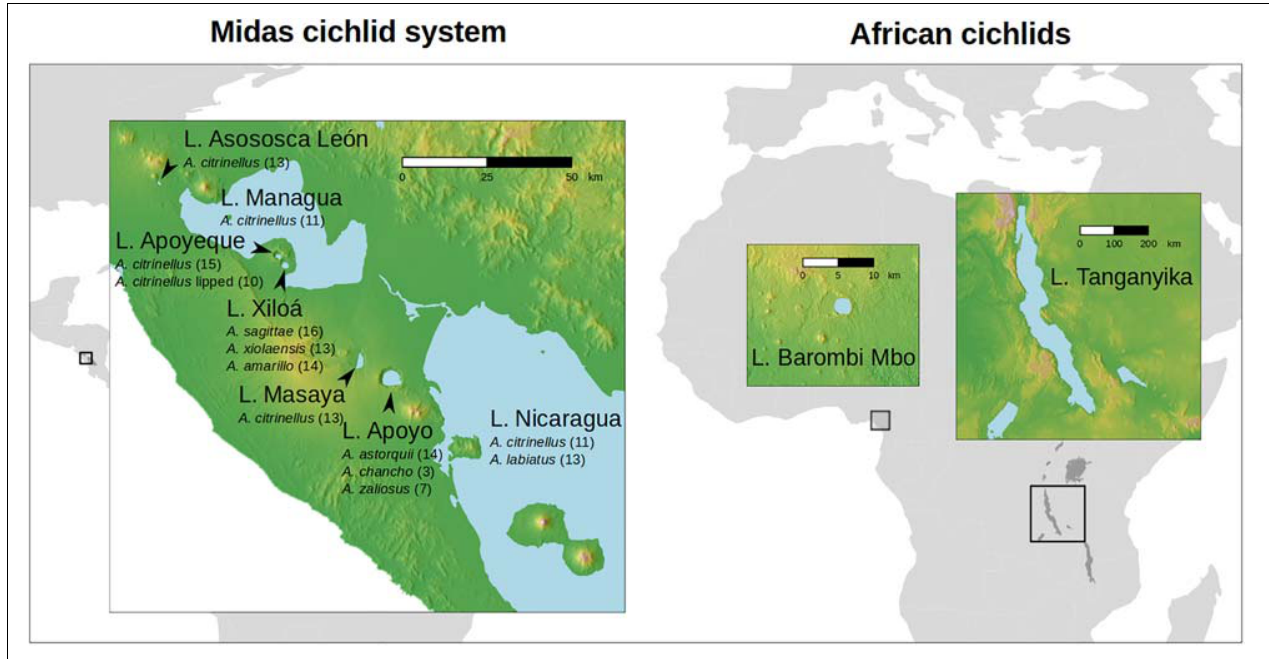
FIGURE 1 | Map of the sampled lakes for the cichlid gut microbiota (seven Central American and two African lakes). Total samples ( N = 274 specimens) encompassed 42 species. For Midas cichlids, sampled species ( N = 13) and specimens ( N = 158) are given below the lake name (number of individuals per species is shown in parentheses, see Supplementary Table S1 for metadata). For the two African lakes, Barombi Mbo and Tanganyika, data were obtained from Baldo et al. (2017) (specimens, N = 116, for details on species and diet see Supplementary Table S1 of this previous